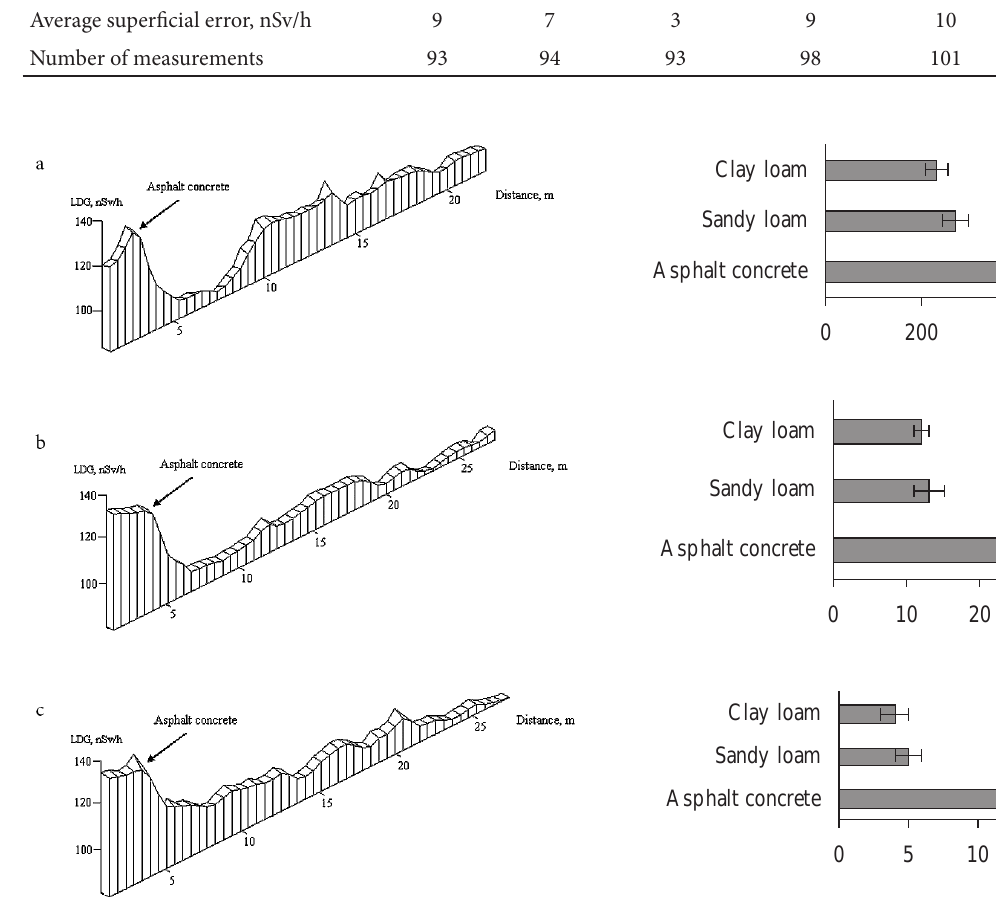
Fig. 4. EDR values near the highway: a – Vilnius–Panevėžys, 12 th km; b – Vilnius–Panevėžys, 122 nd km; c –Vilnius–Klaipėda, 283 rd km